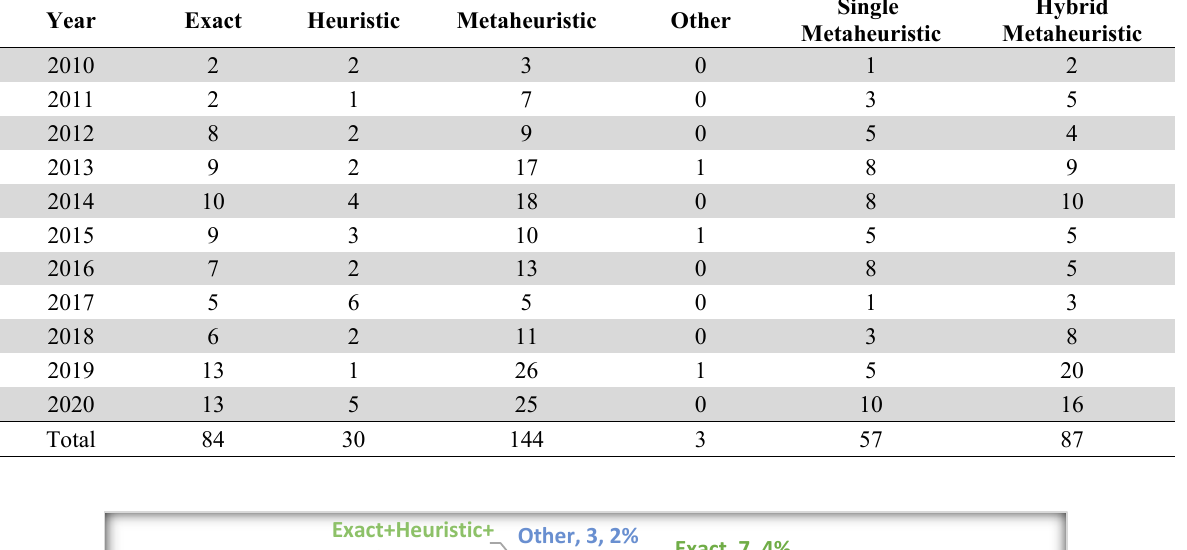
Number of HFS articles according to years based on solution algorithms